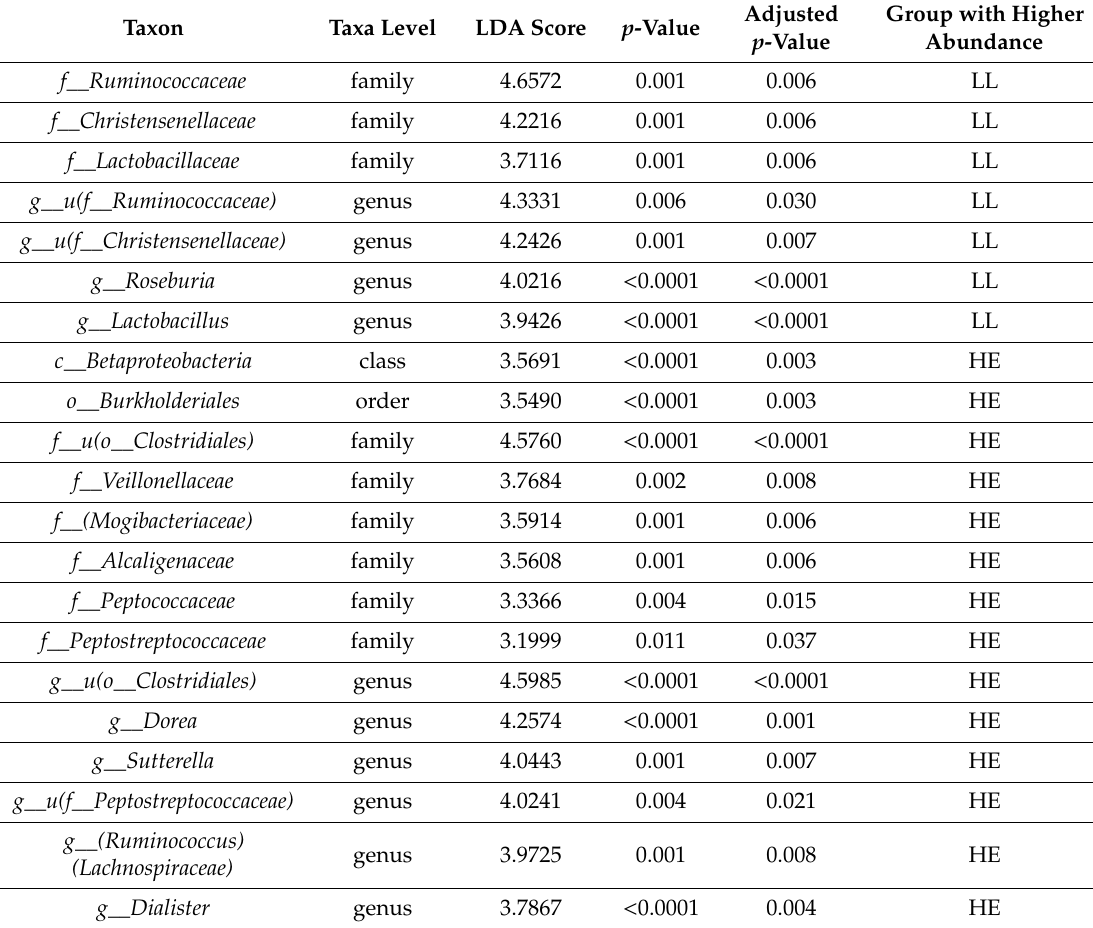
Table 1. Bacteria with significantly di ff erent abundance in the LL and HE